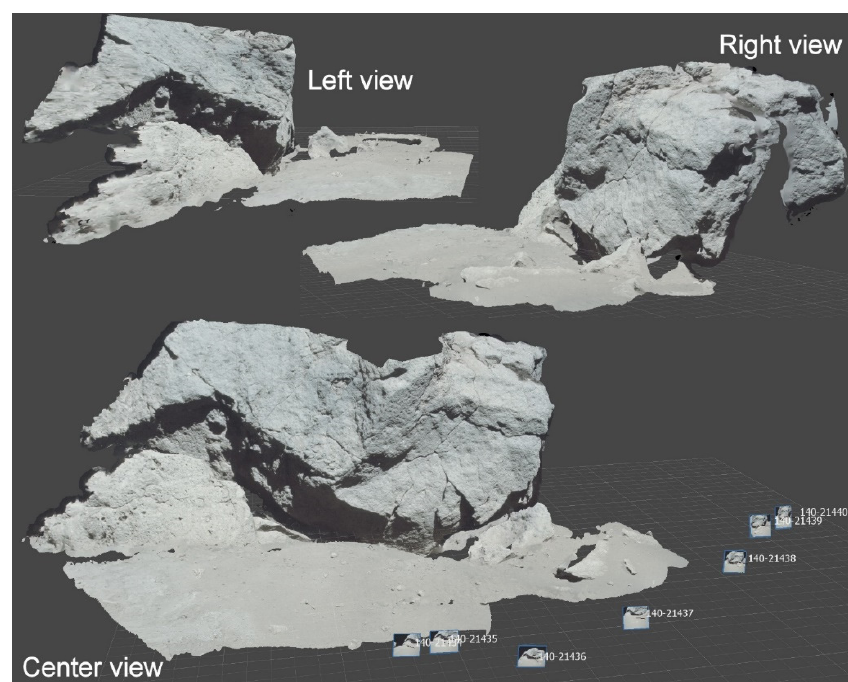
Figure 6. Photogrammetric reconstruction (textured 3-D model) of fragments 2 and 3 at Station 6. The location and orientation of the seven entry Apollo images AS17-140-21434 to AS17-140-21440 as computed by Metashape are indicated by annotated squares. A significant part of the ground underneath the boulders was reconstructed thanks to significant overlap in the entry images.